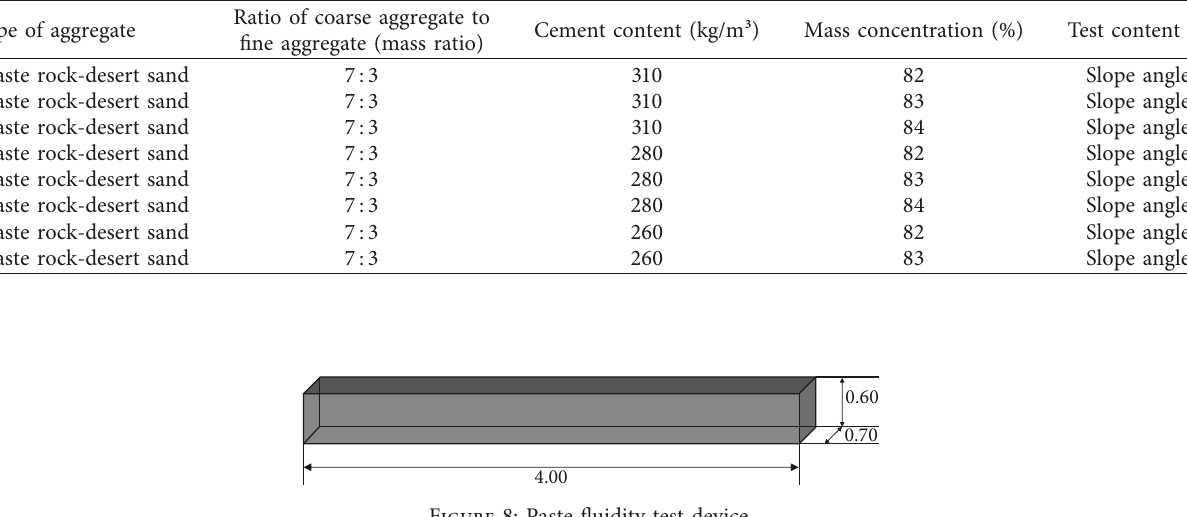
Table 7: The scheme of the paste stope fluidity test.